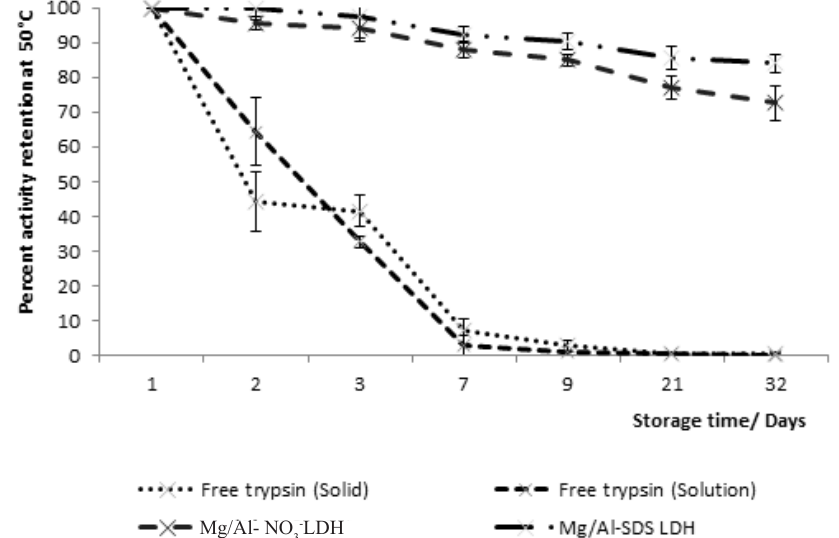
Figure 6: Plot of percent retention of activity at 50.0 °C vs. storage